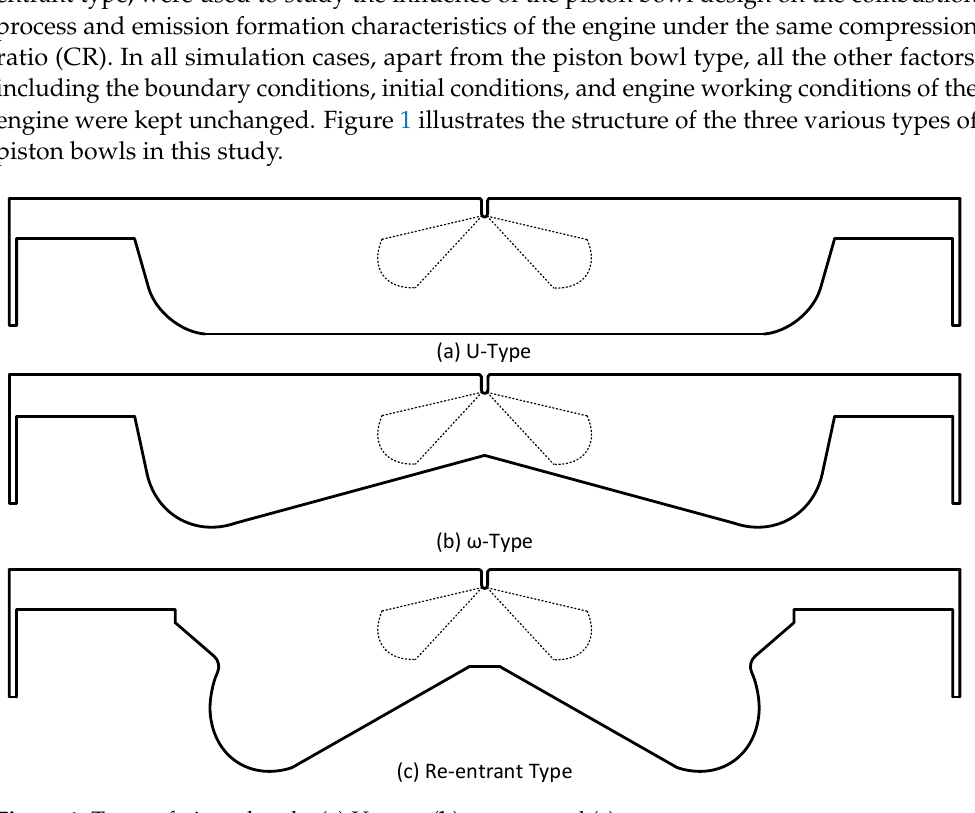
Figure 1. Types of piston bowls: ( a ) U-type, ( b ) ω -type, and ( c ) re-entrant